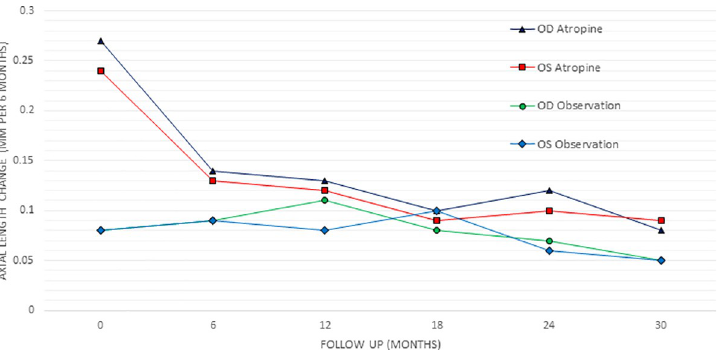
Fig 2. Graph showing change in the axial length in the observation and atropine 0.01% group over each six months.